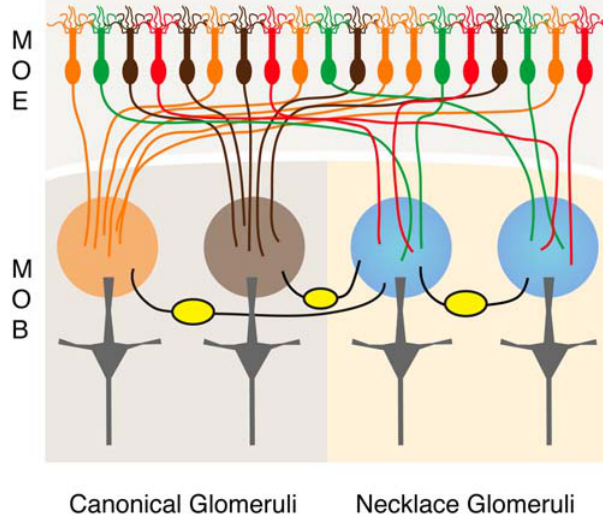
Figure 3. Schematic of sensory neuron and interneuron innervation of necklace glomeruli. The MOE contains numerous sensory neurons (top), including: canonical OSNs that all express OMP but which express different ORs (orange, brown); GC-D/PDE2-express- ing OSNs (red); and OMP-positive/PDE4A-negative neurons (green). Canonical OSNs expressing the same OR converge on the individual canonical glomeruli (orange, brown circles) in the MOB, providing homogeneous sensory input to those structures. GC-D/PDE2-positive neurons innervate necklace glomeruli (blue circles), as do OMP-positive/ PDE4A-negative neurons. Juxtaglomerular interneurons in the glomer- ular layer (yellow ovals) connect individual necklace glomeruli with other necklace glomeruli and with near and distant canonical glomeruli. Mitral cells (gray, bottom) innervating necklace glomeruli display a typical MOB mitral cell